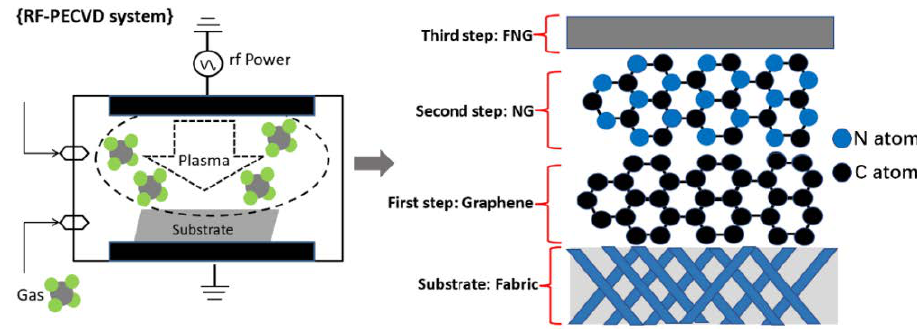
Figure 1. Schematic of graphene, NG and FNG films synthesized by PECVD technology.